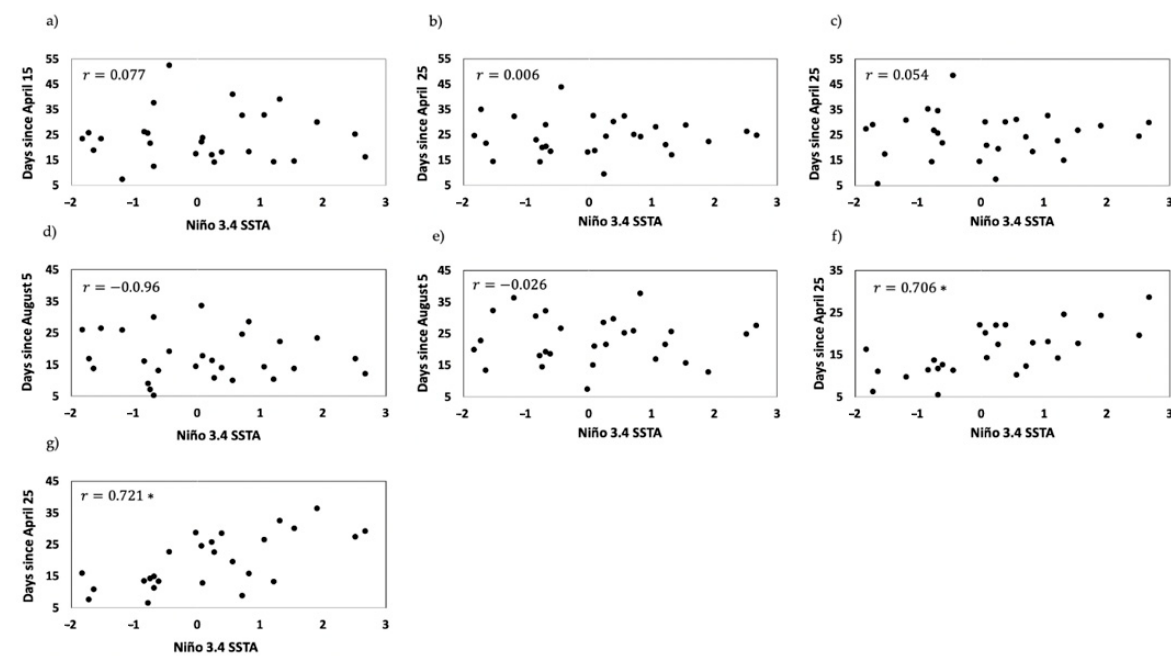
Figure 5. Scatter diagram between Niño 3.4 seas surface temperature anomaly (SSTA) (x-axis) and zonal mean onset dates (y-axis) for ( a ) Northwest (Z1), ( b ) Northeast (Z2), ( c ) North Central (Z3), ( d ) Central Coast (Z4), ( e ) South Central Coast (Z5), ( f ) Central Highlands (Z6), and ( g ) South (Z7) agroclimatic zones during 1980–2010. The Pearson’s correlation coefficient (r) is also displayed for each zone. Asterisk indicates that the r values are statistically significant at 95% level.